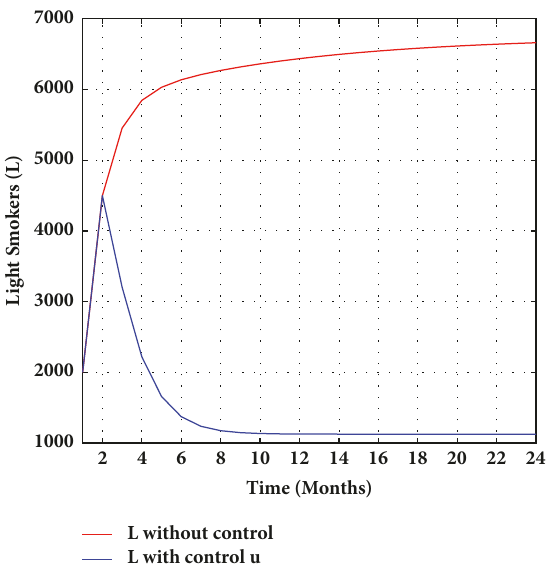
Figure 2: The evolution of the light smokers with and without